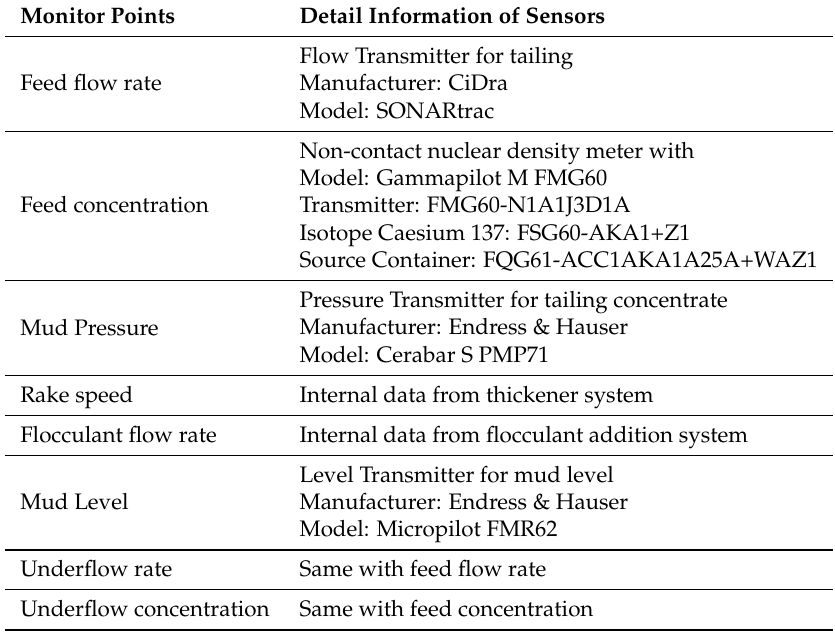
Table 4. Details of sensors in data collection